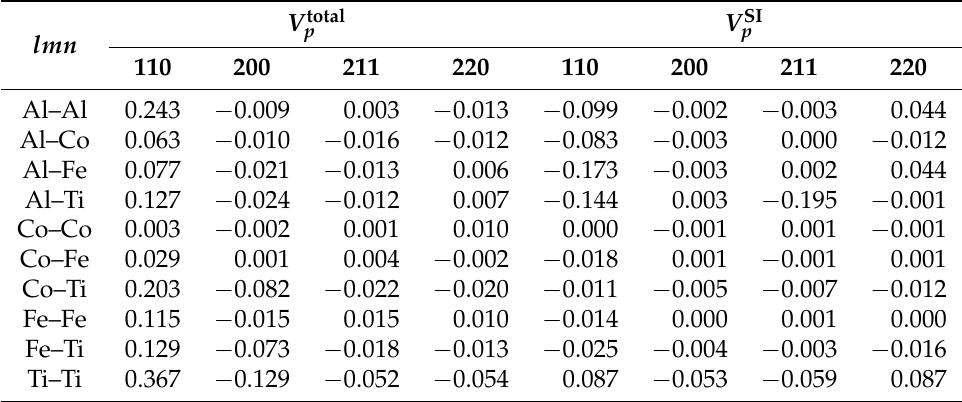
Table 1. Pair interaction (in eV) of solute pairs in fcc Ni matrix. lmn : Coordination shell